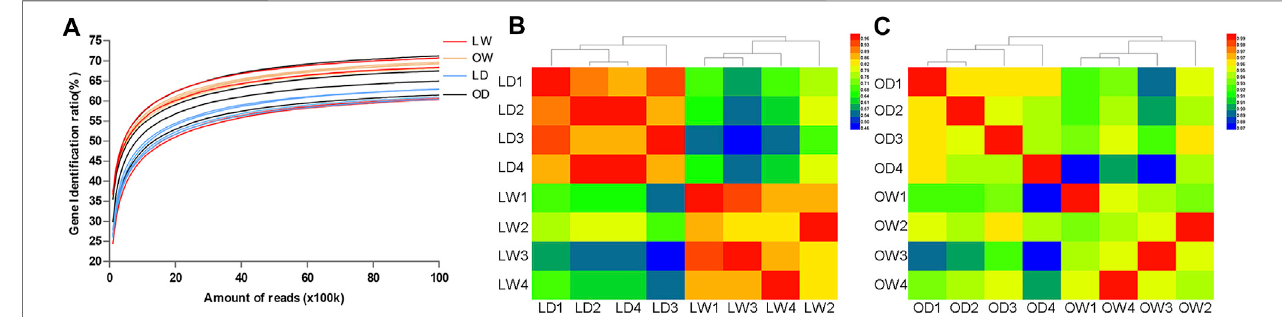
FIGURE4|(A) Saturationcurvesanalysisofallthebiologicalsamples. (B) Correlationanalysisandhierarchicalclusteringofallthebiologicalsamples.LW,liverfrom wild S. o ’ connori ; LD, liver from domestic S. o ’ connori ; OW, oocyte from wild S. o ’ connori ; OD, oocyte from domestic S. o ’ connori